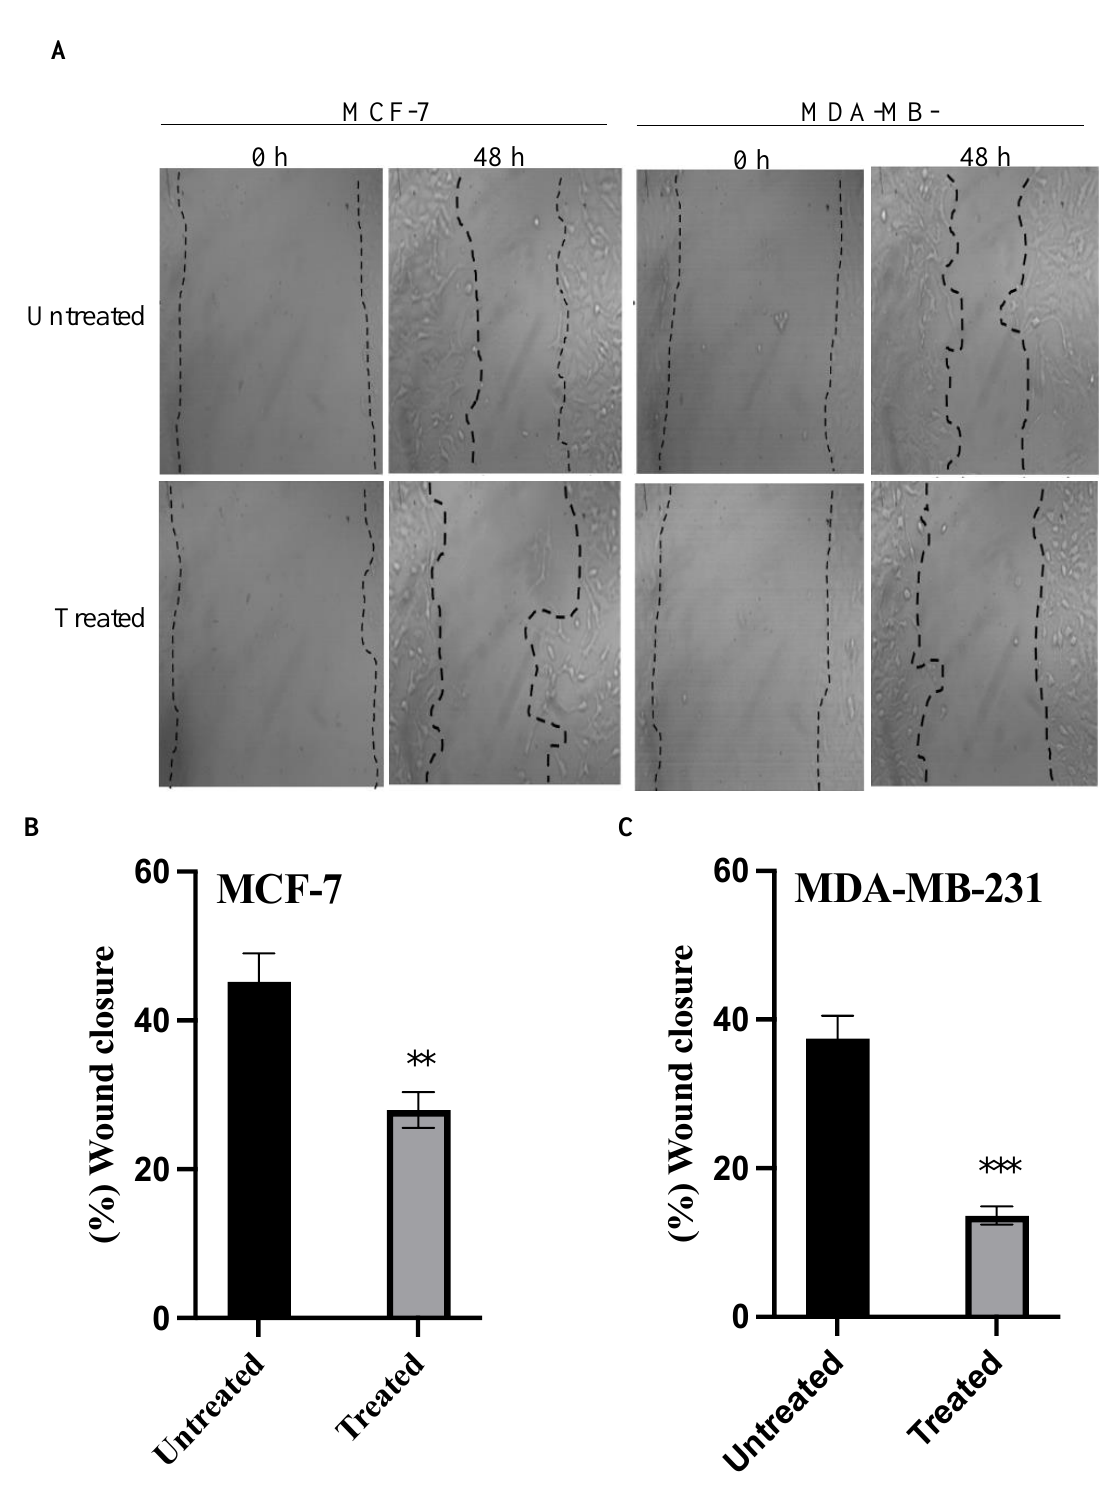
Figure 5. The effect of azilsartan on the migration ability of MCF-7 and MDA-MB-231 breast cancer cell lines. ( A ) Representative photos taken at 0 and 48 h for untreated and treated cells with the IC 50 of azilsartan after making the scratch area for MCF-7 and MDA-MB-231 cancer cells. Magnification: × 40. ( B , C ) Percentage of the wound closure for MCF-7 and MDA-MB-231 cancer cell lines, respectively. Data represent mean ± SD, n = 3. Significant difference was analyzed by student t test, where ** p < 0.01, *** p < 0.001, compared to untreated cells.